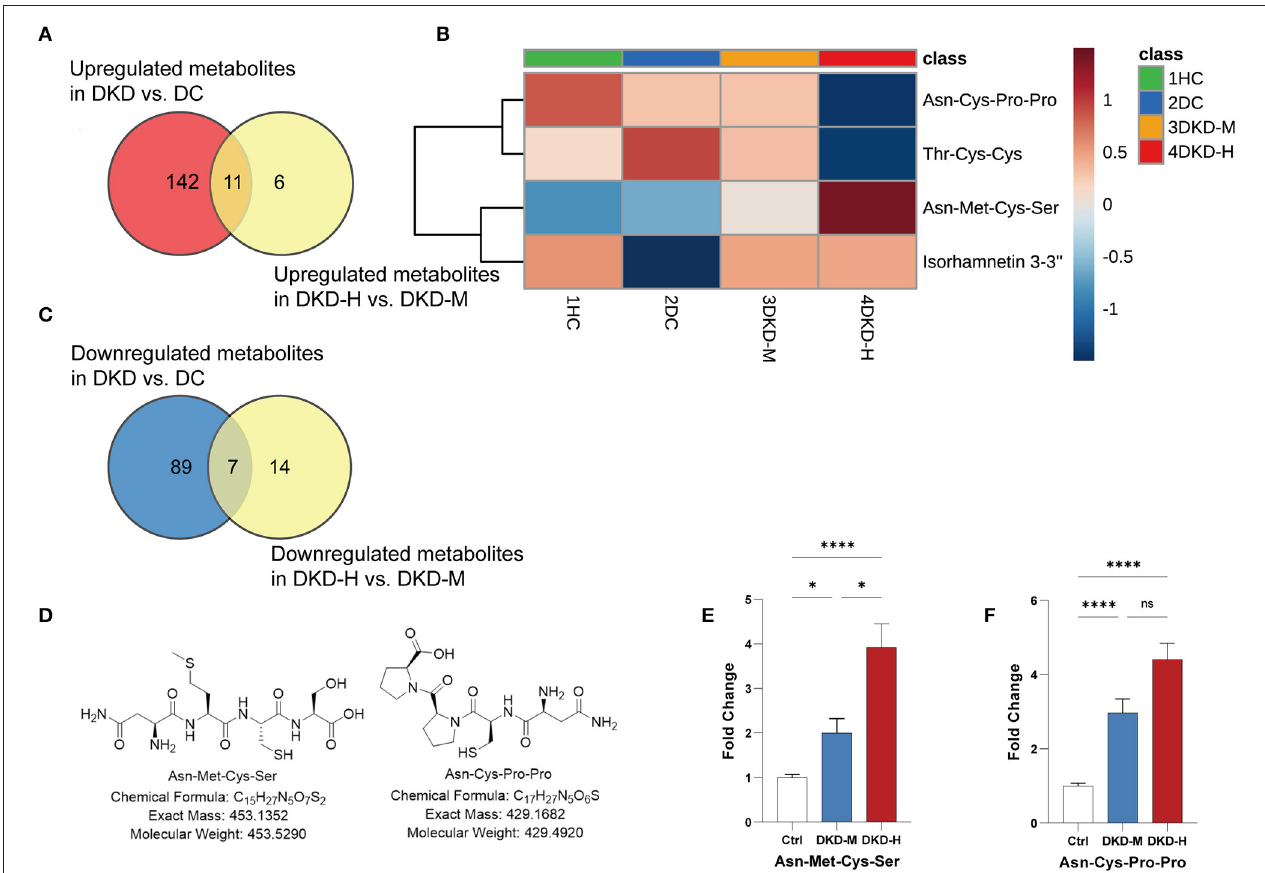
FIGURE 5 | Asn-Met-Cys-Ser and Asn-Cys-Pro-Pro peak count changed with the progression of diabetic kidney disease. (A) Venn diagrams showing the number of upregulated (fold change ≥ 1.5) metabolites in DKD vs. DC and DKD-heavy vs. DKD-moderate ( p < 0.05). (B) Venn diagrams showing the number of downregulated (fold change ≤ 0.67) metabolites in DKD vs. DC and DKD-heavy vs. DKD-moderate ( p < 0.05). (C) Heatmap of 4 metabolites, Asn-Met-Cys-Ser, Asn-Cys-Pro-Pro, Thr-Cys-Cys and Isorhamnetin 3-(3 ′′ , 6 ′′ -di-p-coumarylglucoside) changed significantly (fold change ≥ 2 or ≤ 2) in the same direction in the comparison of DKD vs. DC and DKD-heavy vs. DKD-moderate. (D) Chemical structural formula, exact mass, and molecular weight of Asn-Met-Cys-Ser and Asn-Cys-Pro-Pro. (E,F) Confirmation of peak counts of Asn-Met-Cys-Ser and Asn-Cys-Pro-Pro in the validation group. Healthy control (HC) ( n = 23), diabetic kidney disease with moderate proteinuria (DKD-M) ( n = 25), and diabetic kidney disease with heavy proteinuria (DKD-H) ( n = 35). The data are shown as the mean ± SEM. * P < 0.05 vs. the corresponding control